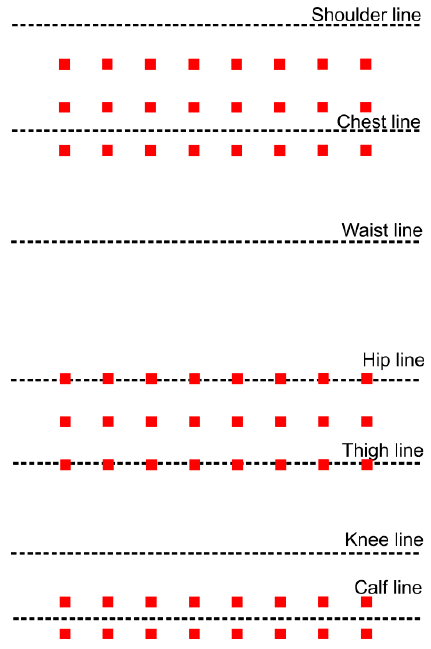
Figure 2. Scheme of the sensors’ arrangement.